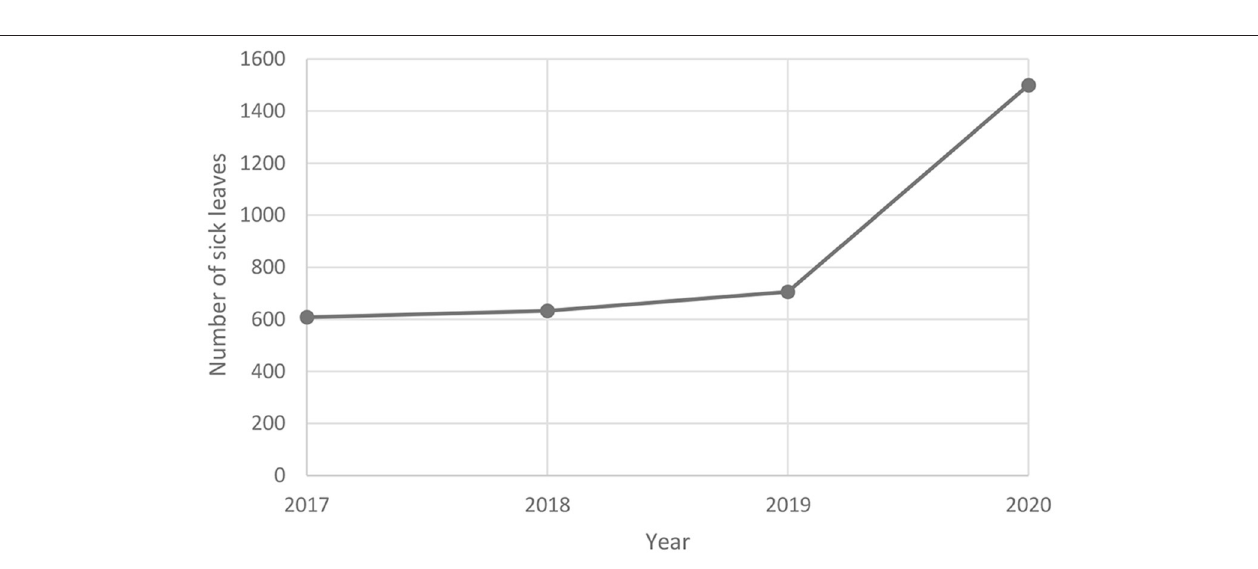
When analyzing suicide attacks by gender, the largest